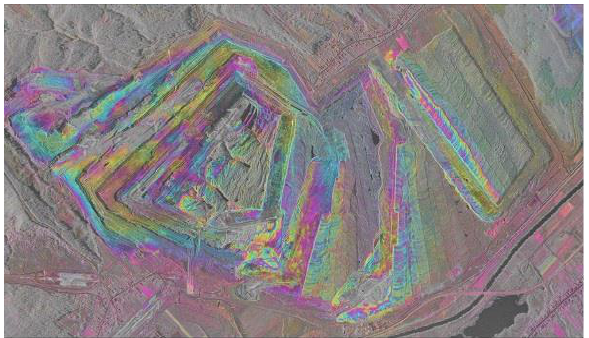
Figure 3.Differential interferogram obtained from 16.11- 27.11.2014 image pair in the radar coordinates. ©DLR, 2014